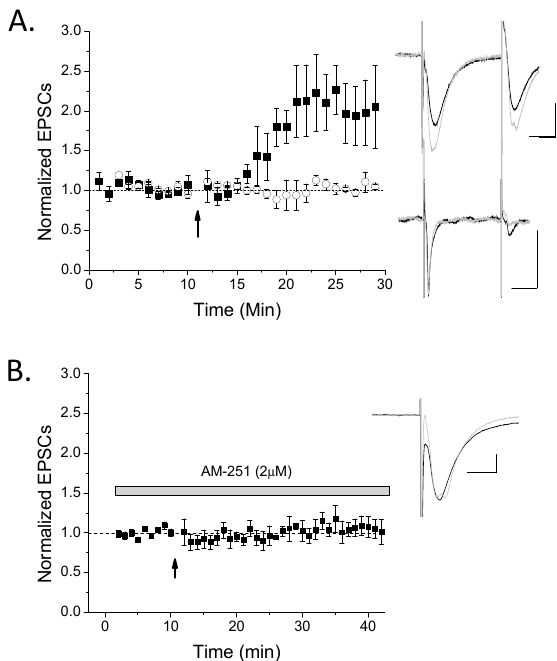
Figure 1. High-frequency stimulus long-term potentiation (HFS-LTP) only occurs in a subset of rat hippocampal oriens interneurons and is cannabinoid receptor (CB1)-dependent. ( A ) Oriens interneurons were recorded in whole cell voltage-clamp mode and 100 Hz high-frequency stimulus (HFS; arrow) while in current clamp mode was used to induce LTP. A majority (67%) of interneurons exhibited significant LTP ( n = 8; ANOVA, p < 0.05), while a minority did not ( n = 4; ANOVA, p > 0.05). ANOVAs were used to compare baseline to post-HFS excitatory postsynaptic currents (EPSCs) in order to group a cell having significant LTP versus no plasticity. These two groups (black symbols, LTP; white symbols, no plasticity) were significantly different from each other ( p < 0.05, t -test). Inset: top traces are an LTP example and bottom traces are a no plasticity example. Traces were taken from 10–12 sweeps just before HFS (black) or ~10–15 min post-HFS (light gray). ( B ) This LTP was significantly blocked by AM-251 ( n = 6; p < 0.05 compared to control LTP), suggesting it is CB1-dependent. Scale bars 100 pA, 10 msec. Plots, mean with s.e.m. Table 1. Summary of RT-PCR data. Individual stratum oriens interneurons from rat hippocampus were extracted for mRNA examination. Cells were sorted by subtype and the SOM+ cells were the most abundant, followed by parvalbumin, calbindin, and calretinin interneurons. Somatostatin and parvalbumin positive cells had the highest percent expression of mRNA for endocannabinoid/eicosanoid enzymes and type I mGluRs. The table represents the number of cells, from the total of each differentiated interneuron subtype as represented by the n value, with positive RT-PCR confirmation of endocannabinoid/eicosanoid-producing enzymes and type I mGluRs (i.e., 6 of 14 confirmed SOM+ cells tested positive of DAGL α